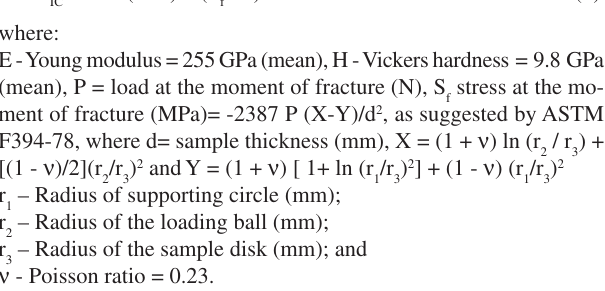
Table 1. Mean and standard deviation of fracture toughness ( IS ) for the three groups. Different letters indicates statistic difference among groups.